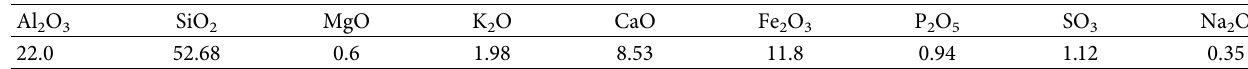
Table 3: Chemical composition of considered FA (wt. %).